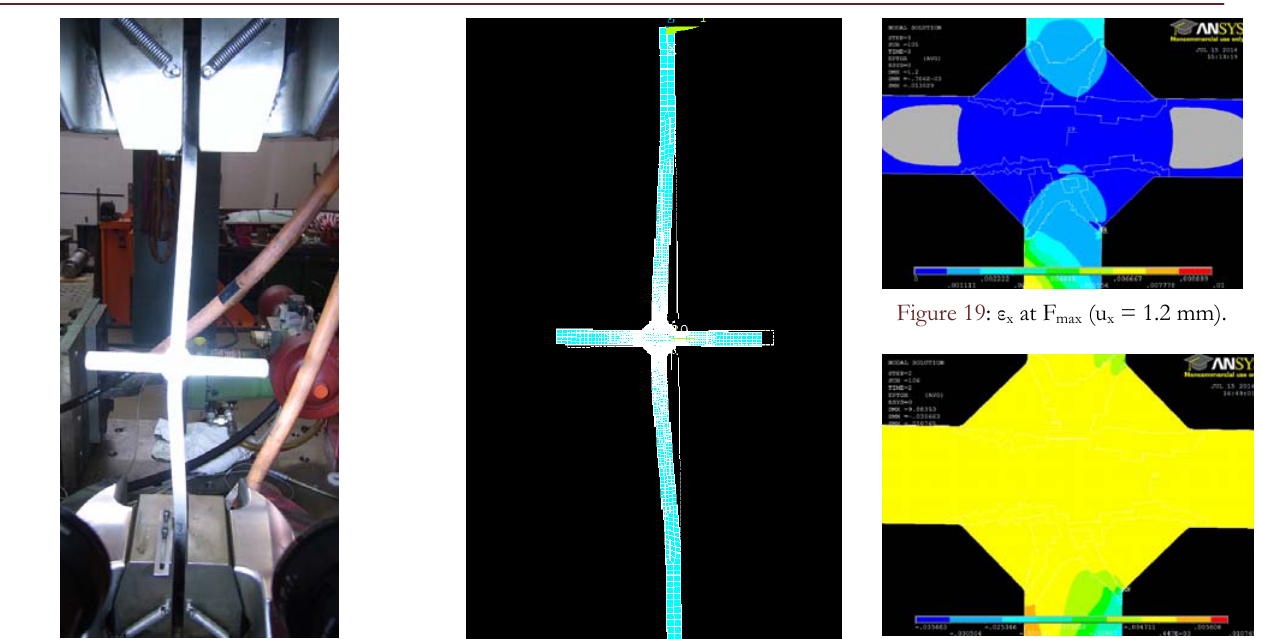
Figure 17: Deformed shape of specimen at F min . Figure 18: FE deformed shape at F min . Figure 20: ε